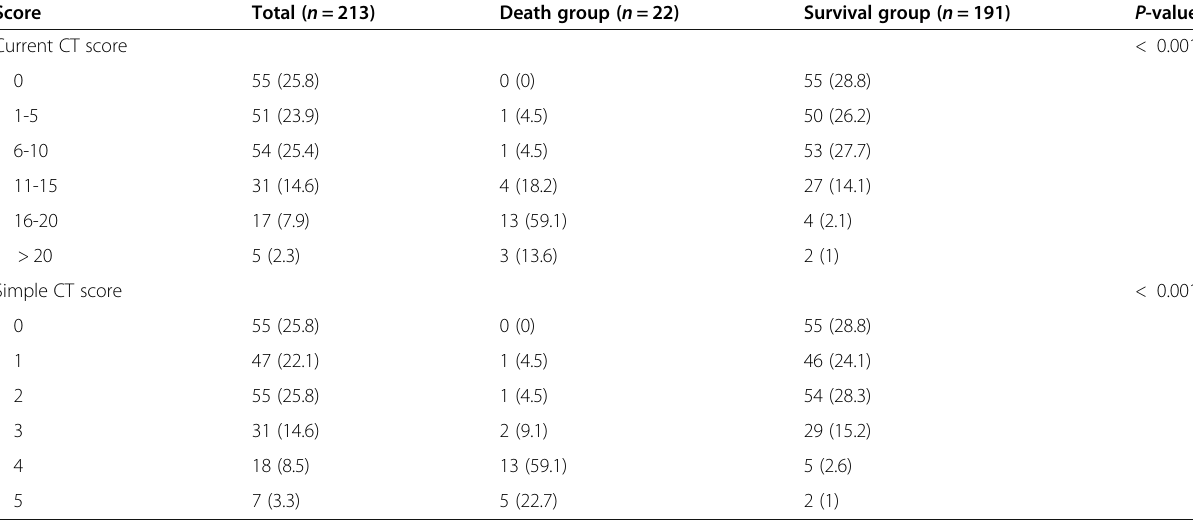
Data represent the number of patients and percentage in parenthesis CT computed